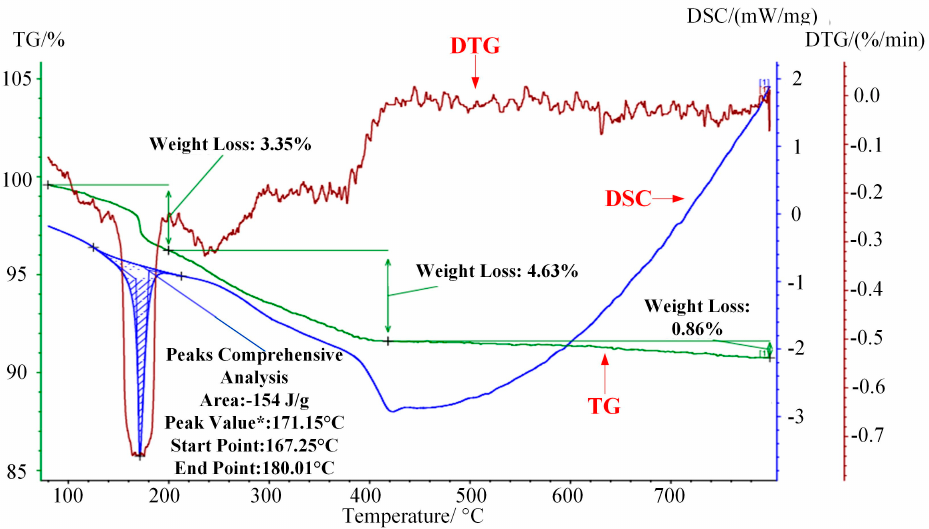
Figure 8. Thermogravimetric analyses-derivative thermogravimetric analysis-differential scanning calorimetry (TG-DSC-DTG) curves of prepared WG1 sample.